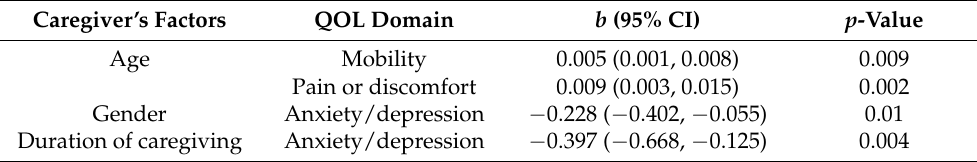
Table 10. Association of caregiver’s sociodemographic factors with QOL Domain based on EQ-5D- 5L questionnaires.